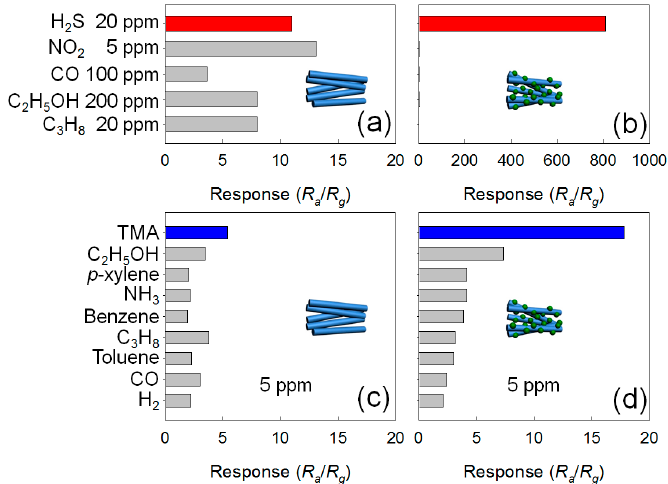
Figure 4. Gas selectivity of ( a ) pristine SnO 2 NW network sensor and ( b ) CuO-decorated SnO 2 NW network sensors at 300 ◦ C; gas selectivity of ( c ) pristine ZnO NW network sensor and ( d ) Cr 2 O 3 -decorated ZnO NW network sensor at 400 ◦ C. Adapted from [80,91] with permission; ( a , b ) [91] Copyright (2009) Elsevier; ( c , d ) [80] Copyright (2012) IOP Publishing Ltd.